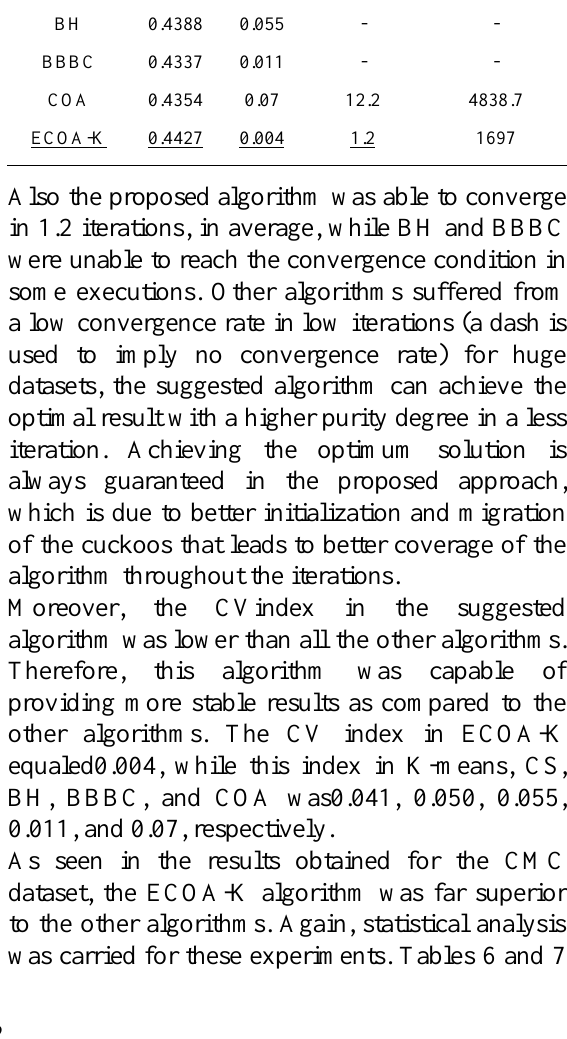
Table 3. Results obtained by statistical analysis of algorithms based on purity criteria on iris dataset. K-means vs. ECOA-K